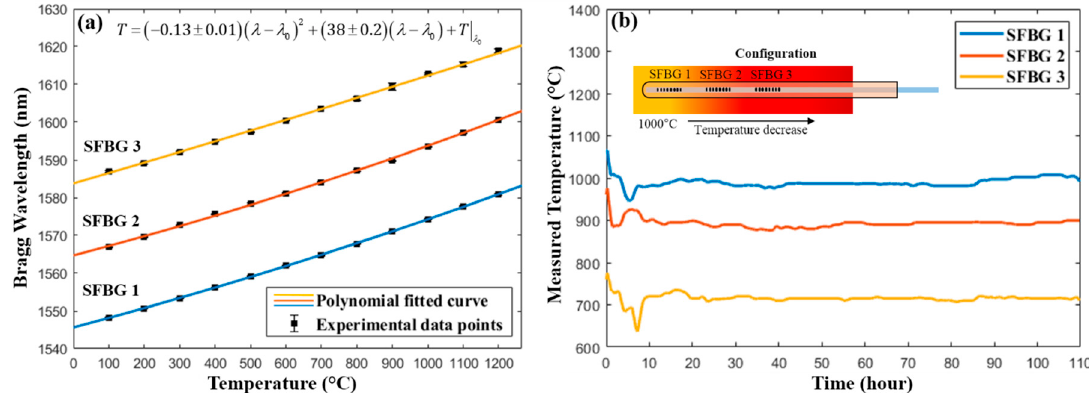
Figure 5. ( a ) Calibration of the temperature response of the SFBGs, where λ (nm) is the measured wavelength, λ 0 (nm) is the Bragg wavelength at room temperature, and T (°C) represents the temperature. ( b ) Evolution of the demodulated temperature during the 110-hour isothermal test. The insert shows the configuration of the FBGs during the test. Note: SFBG = sapphire fiber Bragg grating. FBG = fiber Bragg grating.